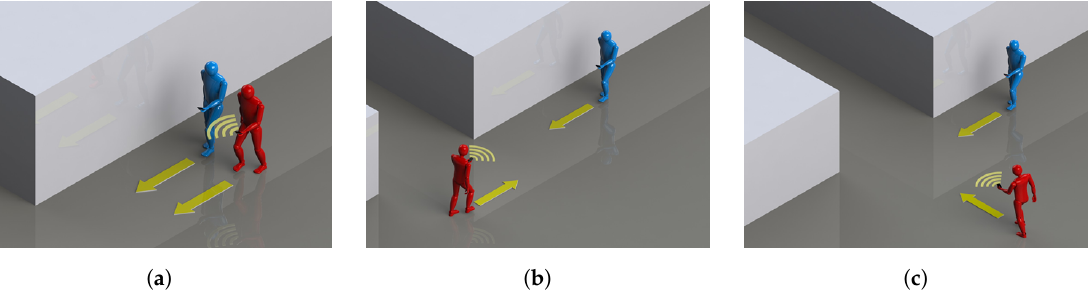
Figure 6. Walking topologies. ( a ) Same heading path, ( b ) Opposite heading path, ( c ) Perpendicular heading